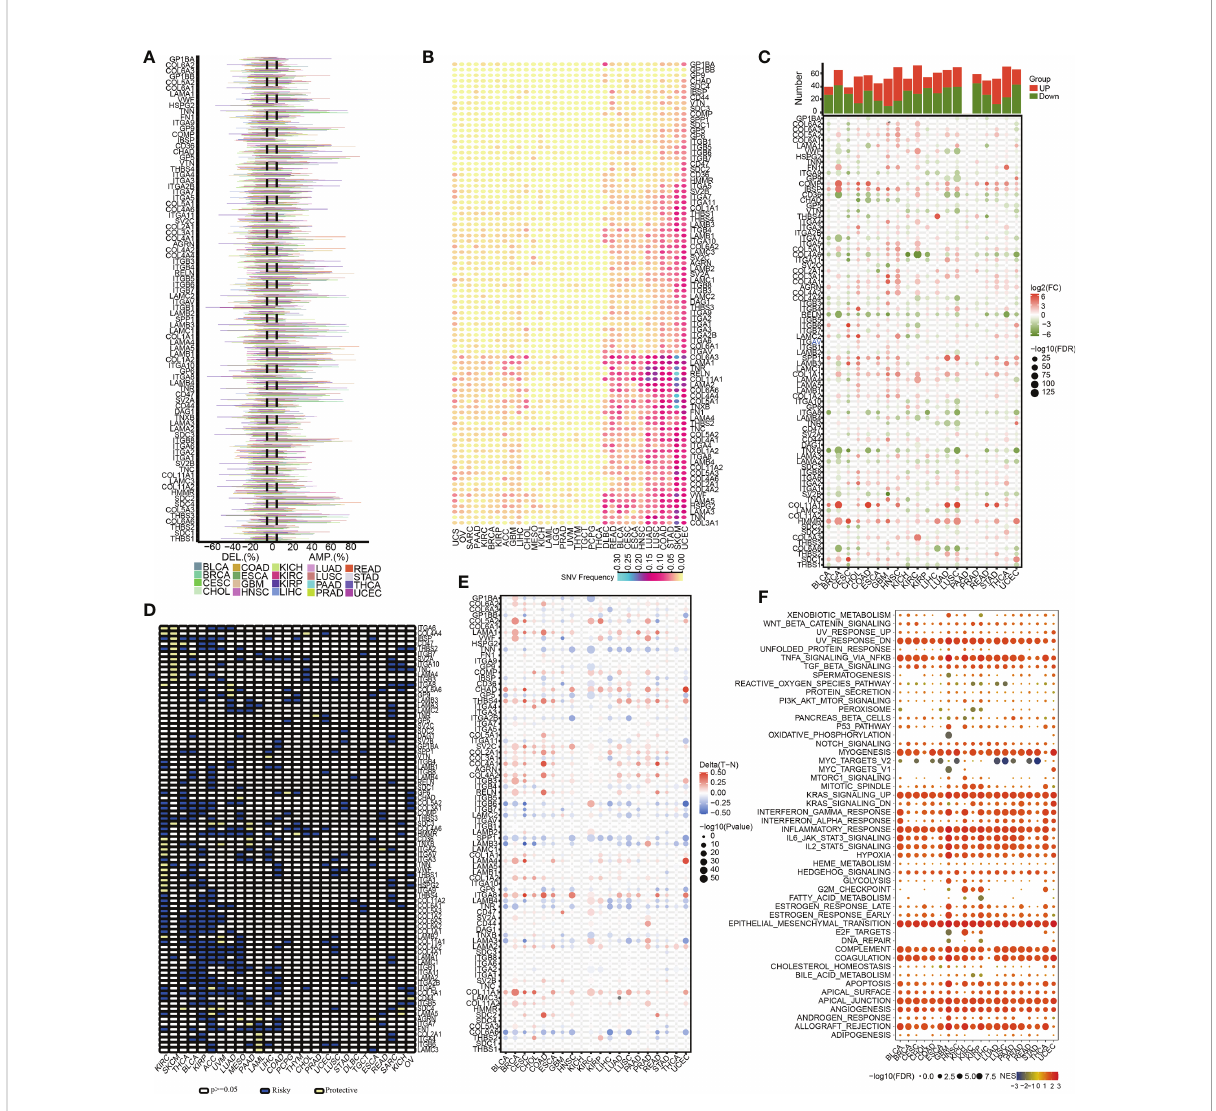
FIGURE 2 The pan-cancer landscape of ECM receptor interaction-related genes. (A) CNV gain and loss frequency data across cancer types. The length of the line represents the variation frequency of the ECM-related genes in pan-cancers. (B) SNV data across cancer types. The mutant frequencies of ECM-related genes in pan-cancers (red color to green color represents low to high). (C) Gene expressions of the ECM-associated genes between tumor and neighboring normal tissues in pan-cancers (P<0.05). (D) Survival landscape of the ECM-related genes among all the types of cancers. The white color represents genes with P > 0.05, and the blue and yellow colors represent risk and protective genes, respectively. (E) The DNA methylation of ECMGs in different tumors (red color to blue color signi fi es high to low). (F) The relationship between cancer signaling and ECMGs (red color to blue color signi fi es high to